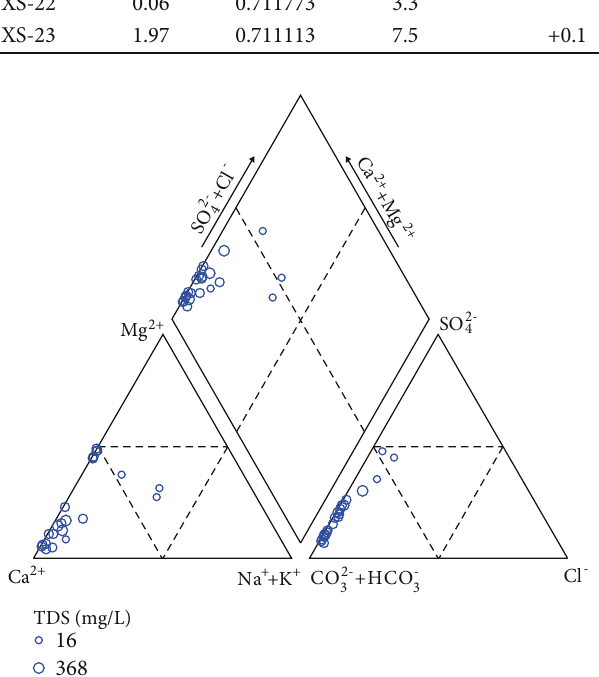
Figure 3: Piper diagram of spring water samples. The HCO and HCO 3- -Ca 2+ · Mg 2+ types were found to be dominant.